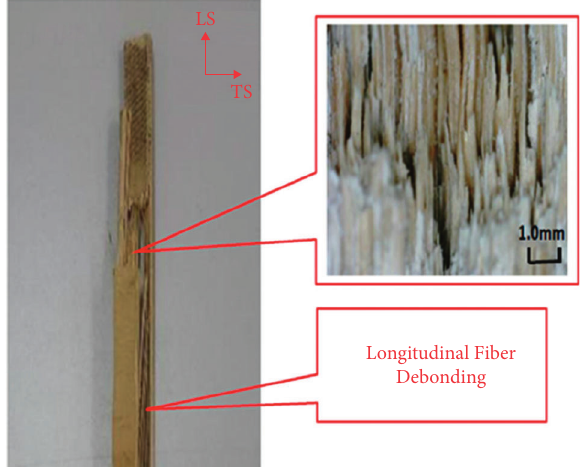
Figure 2: Optical microscope image of the failed direct tensile tested specimens.